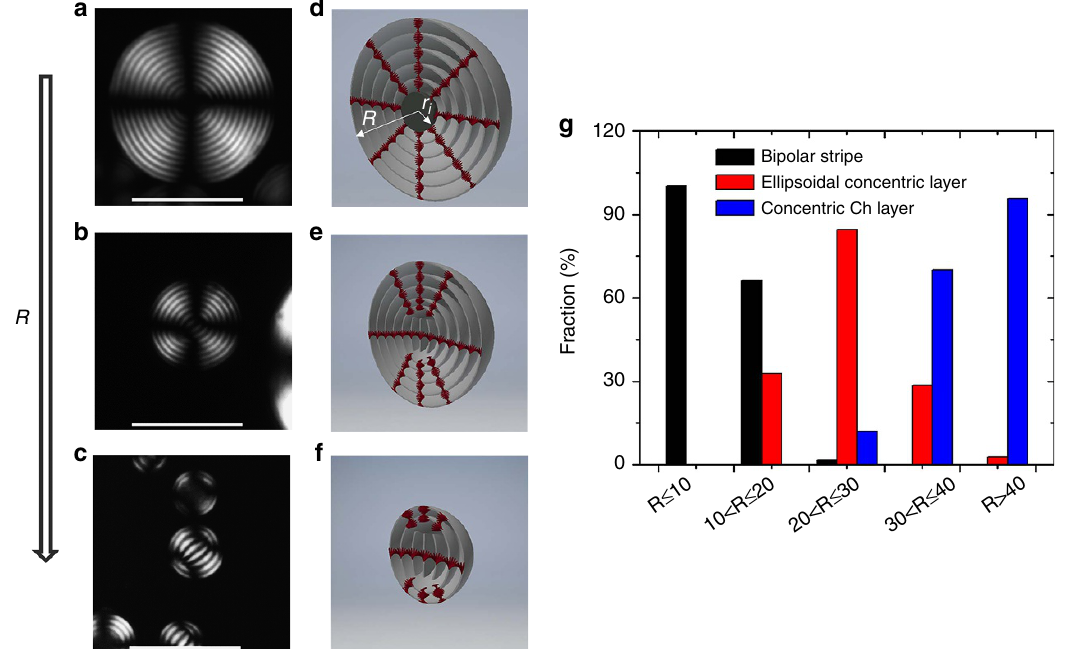
Figure 2 | Confinement-mediated structural transitions in Ch-CNC droplets. ( a – c ) Representative POM images of the Ch–CNC droplets with dimensions in the range of 40 r R r 115 m m ( a ) 10 o R o 40 ( b ) and R r 10 m m ( c ). The scale bars are 50 m m. ( d – f ) Schematics of droplets shown in a , b and c , respectively. ( g ) Distribution of the populations of droplets with concentric Ch layer, bipolar stripe and ellipsoidal concentric layer structures. f 0 ¼ 0.048. For each population, at least, 60 droplets were